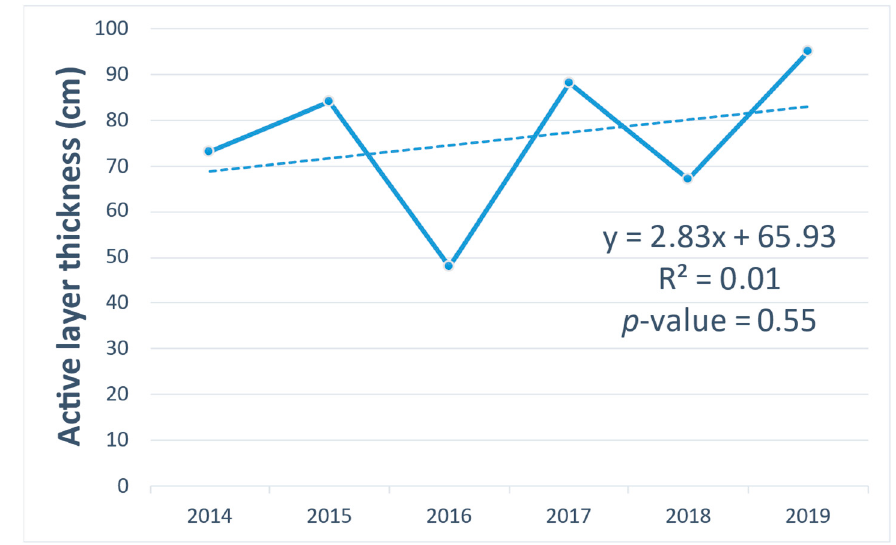
Figure 8. Active layer thickness from 2014 to